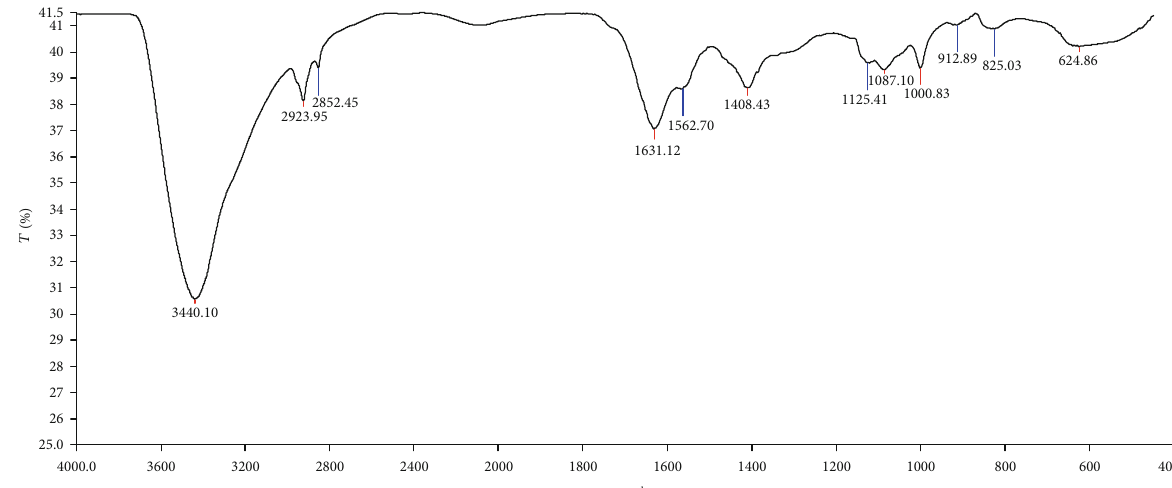
Figure 2: The FTIR spectrum of the cadmium sul fi de nanoparticles biosynthesized by Aspergillus niger (RCMB 002002).